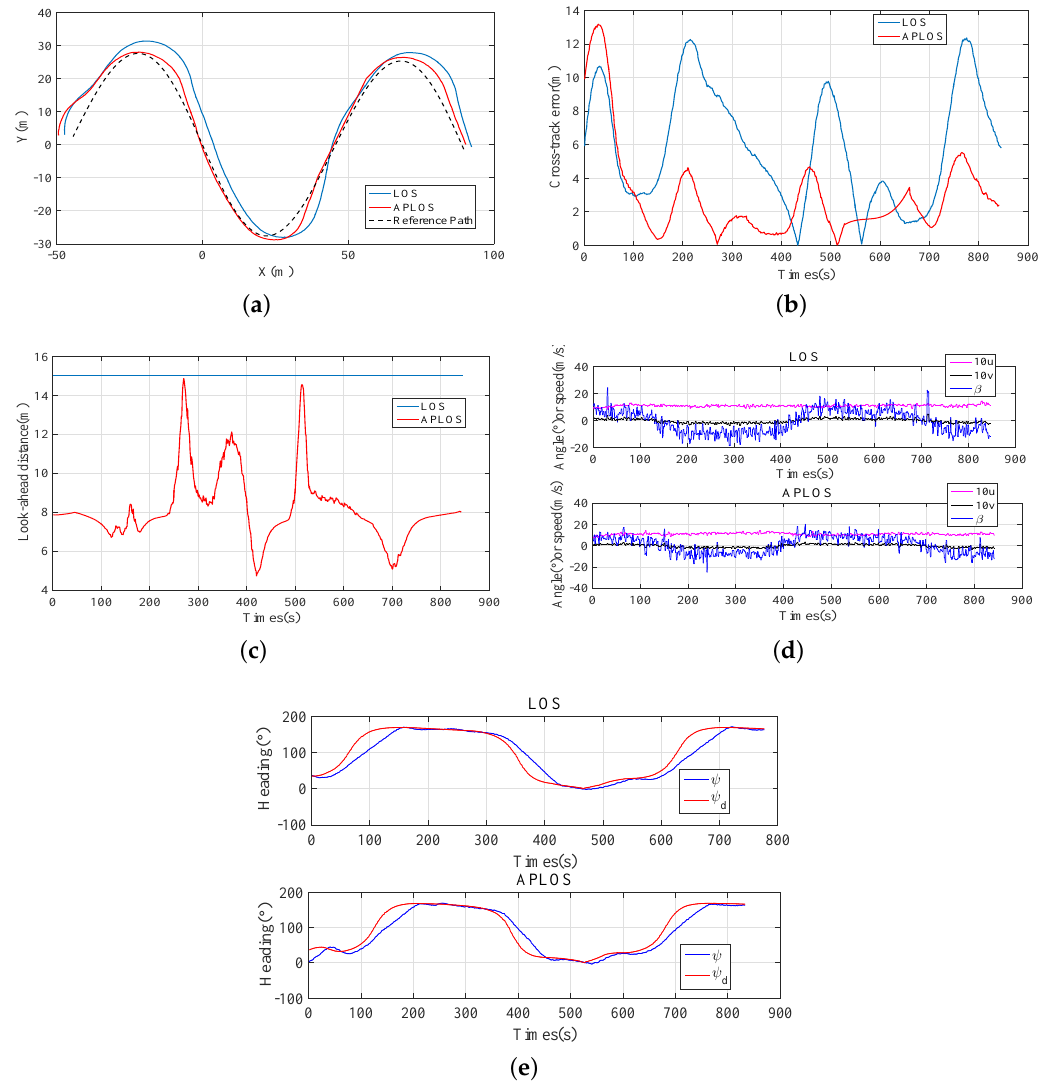
Figure 19. Sinusoidal path following ( u = 1 m/s). ( a ) comparison of trajectory; ( b ) comparison of cross-track error; ( c ) comparison of look-ahead distance; ( d ) comparison of velocity and drift angle; ( e ) comparison of heading